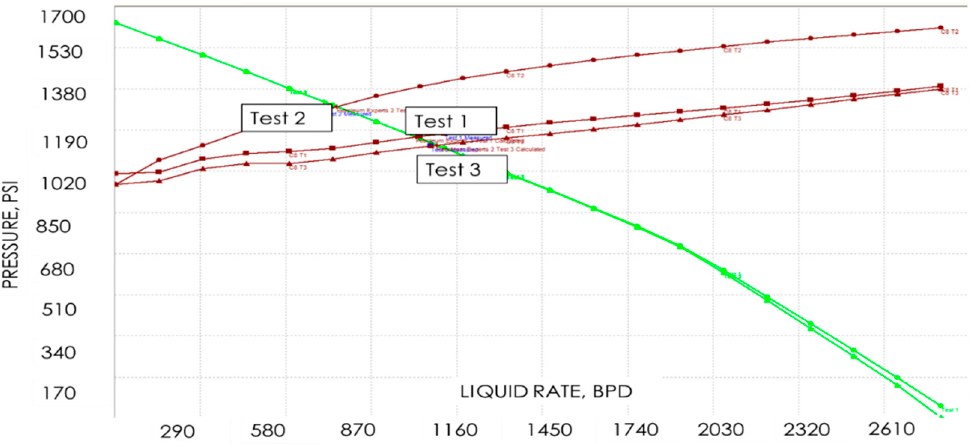
Figure 8. PROSPER matching to the previous well test.